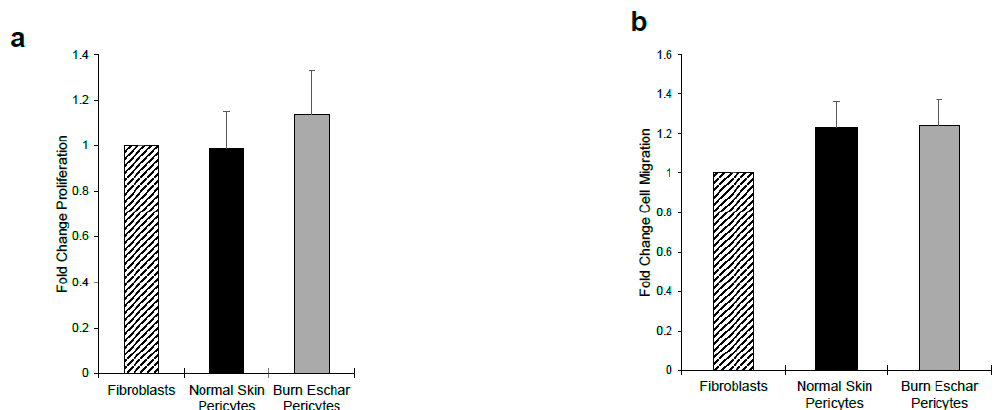
Figure 7. Cell proliferation and migration is unchanged between normal skin and burn eschar pericytes. Analysis of ( a ) cellular proliferation using the MTT assay and ( b ) in-vitro migration using the scratch assay shows no difference between normal and burn eschar pericytes. Cell proliferation assay was performed using five different cultures of normal skin- and burn eschar-derived pericytes and cell migration assay was performed using six different cultures each of normal skin- and burn eschar-derived pericytes. Statistical analysis was performed using one-way ANOVA with p < 0.05 considered statistically significant. Data is represented as mean ± SEM values.